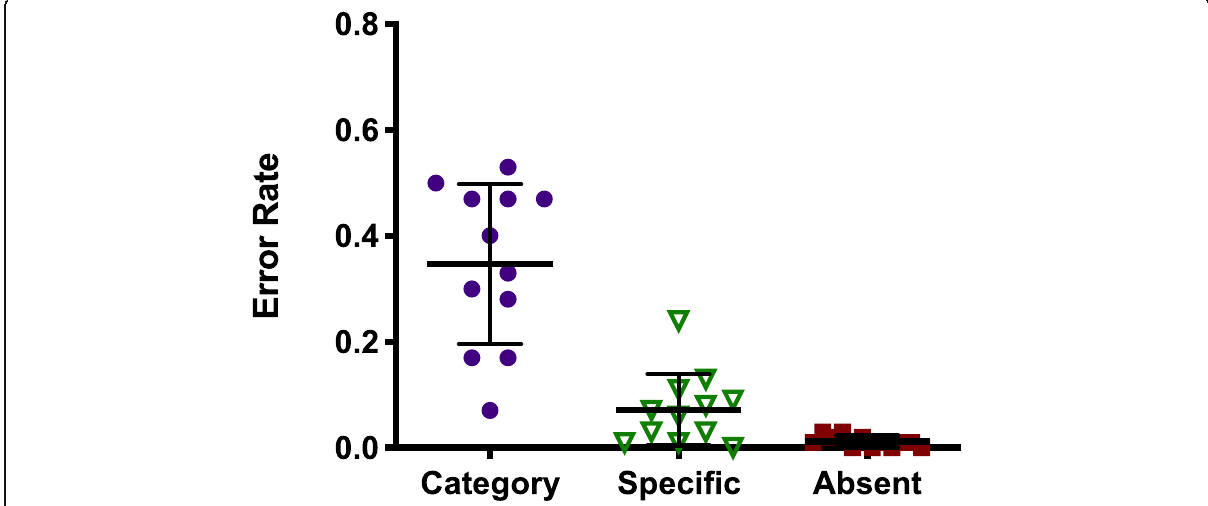
Fig. 6 Error rates in all conditions of Experiment 2. Categorical targets are still missed much more than specific targets. Specific errors may have increased slightly, but false alarms are still